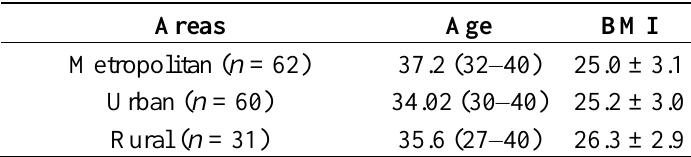
Table 2. Age (mean and range) and body mass index (BMI) (mean ± SD) of men enrolled in the three